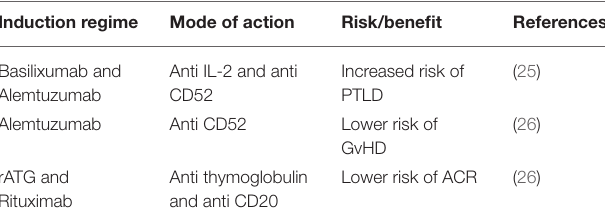
TABLE 1 | Summary of risks and benefits of new induction regimes pre-intestinal